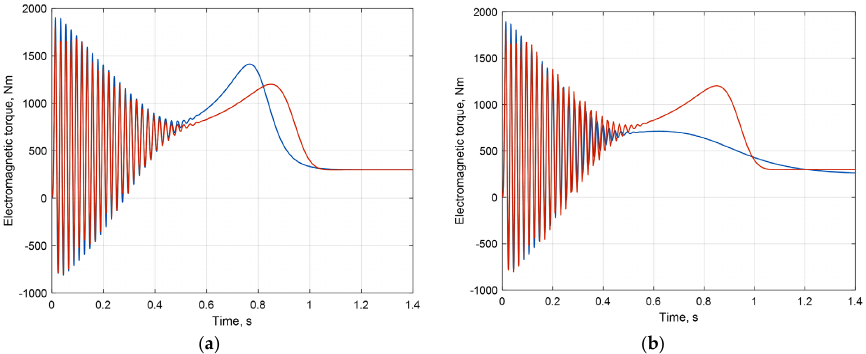
Figure 13. Calculated electromagnetic torque of IM: Runge–Kutte method of the 3rd order (ode3, blue) ( a ), the improved Euler method (ode2, blue) ( b ), and etalon result (red). Table 1. Speed of response for calculation time of 1.4 s corresponding to 500,000 points.